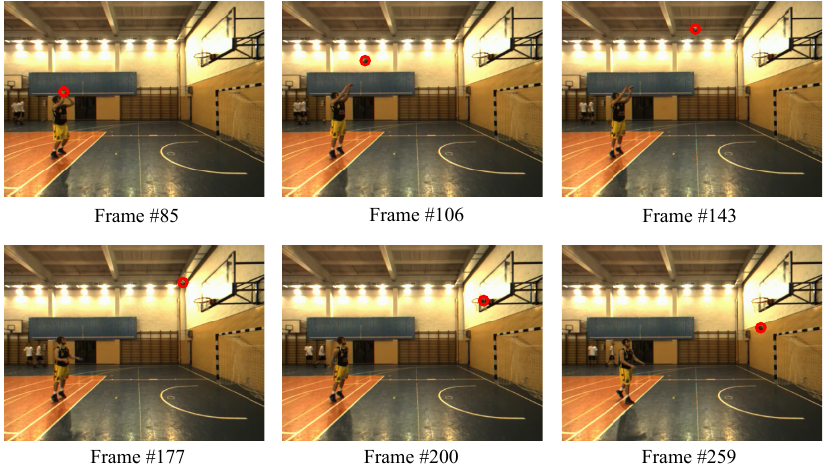
Figure 5. Ball tracking in selected frames of sequence s11.